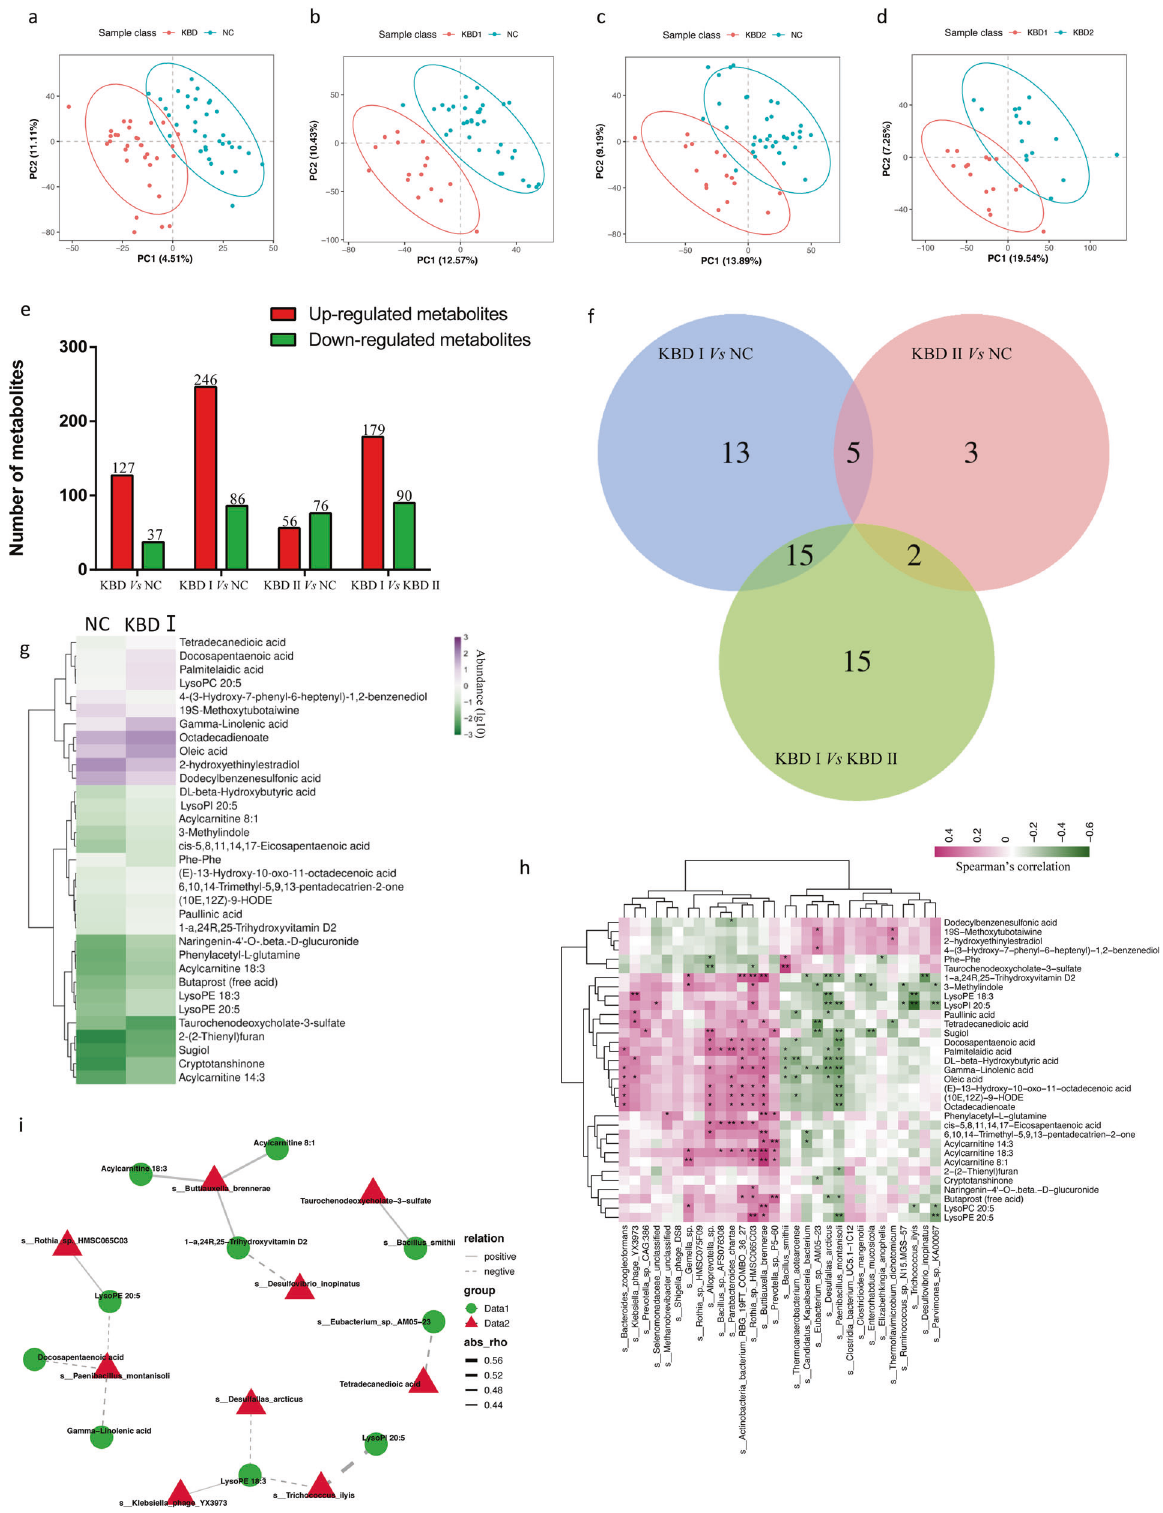
Fig. 4 The aberrant metabolic patterns in KBD (grade I and II) compared with normal controls. a – d The clustering analyses of partial least- square discriminant analysis (PLS-DA). e Differential regulated metabolites among KBD grade I, II and NC group. f Venn diagram displaying the common signi fi cantly different metabolites among three groups. g Heat map of the 32 idms2 signi fi cantly different metabolites across grade I KBD and normal controls. Metabolites >2-fold changes, VIP ≥ 1, P < .05 (T test). h Correlations between species and metabolites. The top 30 species were detected in Metagenomic data. Metabolites >2-fold changes between grade I KBD and normal controls, with P < 0.05 (T test), VIP ≥ 1. The correlation effect is indicated by a color gradient from green (negative correlation) to red (positive correlation). * P < 0.05, ** P < 0.01, T test. i The correlation network of signi fi cantly different metabolites and species across grade I KBD and normal controls, abs_rho means abundances correlation coef fi cient. Cell Death and Disease (2021)